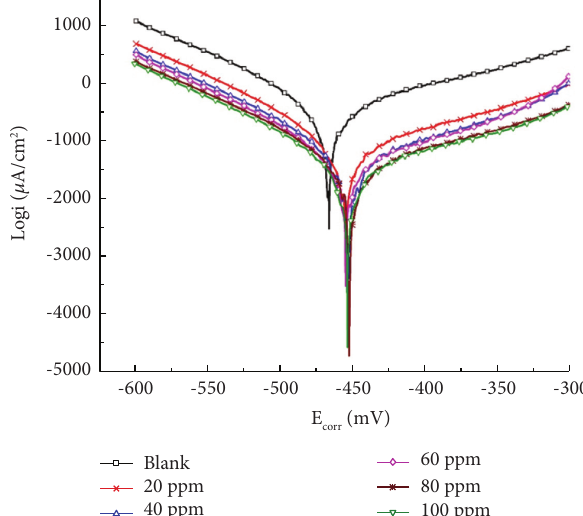
Figure 2: Polarization plots for mild steel electrode with AMP’s different concentrations in acidic medium (1M